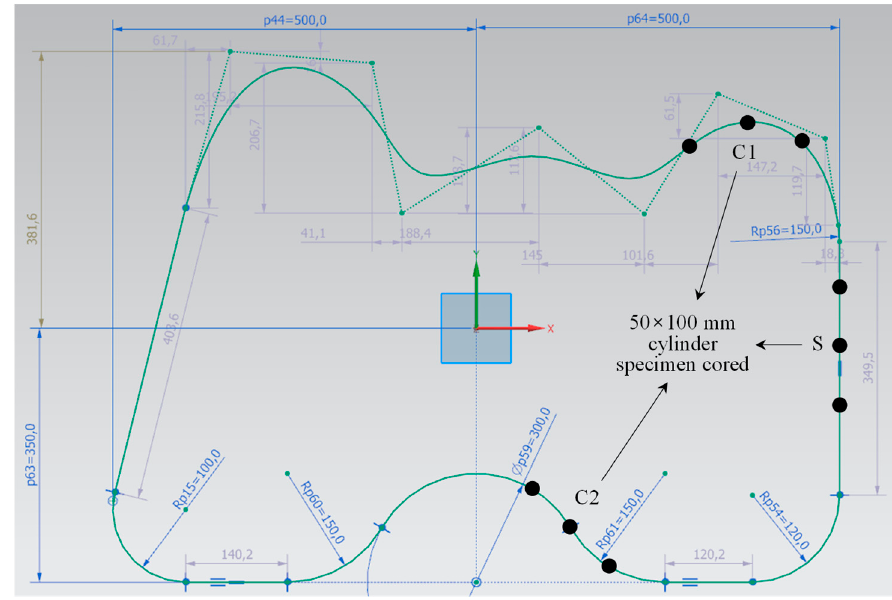
Figure 19. Designed curved shape for printing test.